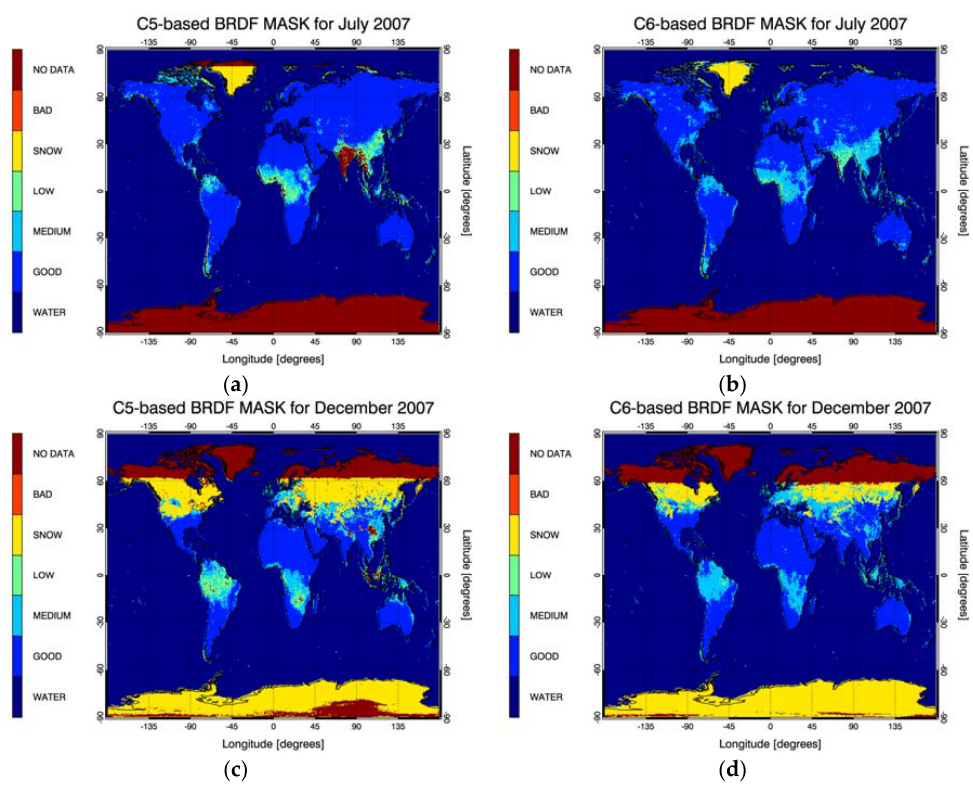
Figure 1. RTTOV Bidirectional Reflectance Distribution Function (BRDF) mask and quality index: ( a ) For July 2007 based on C5; ( b ) For July 2007 based on C6; ( c ) For December 2007 based on C5; ( d ) For December 2007 based on C6.